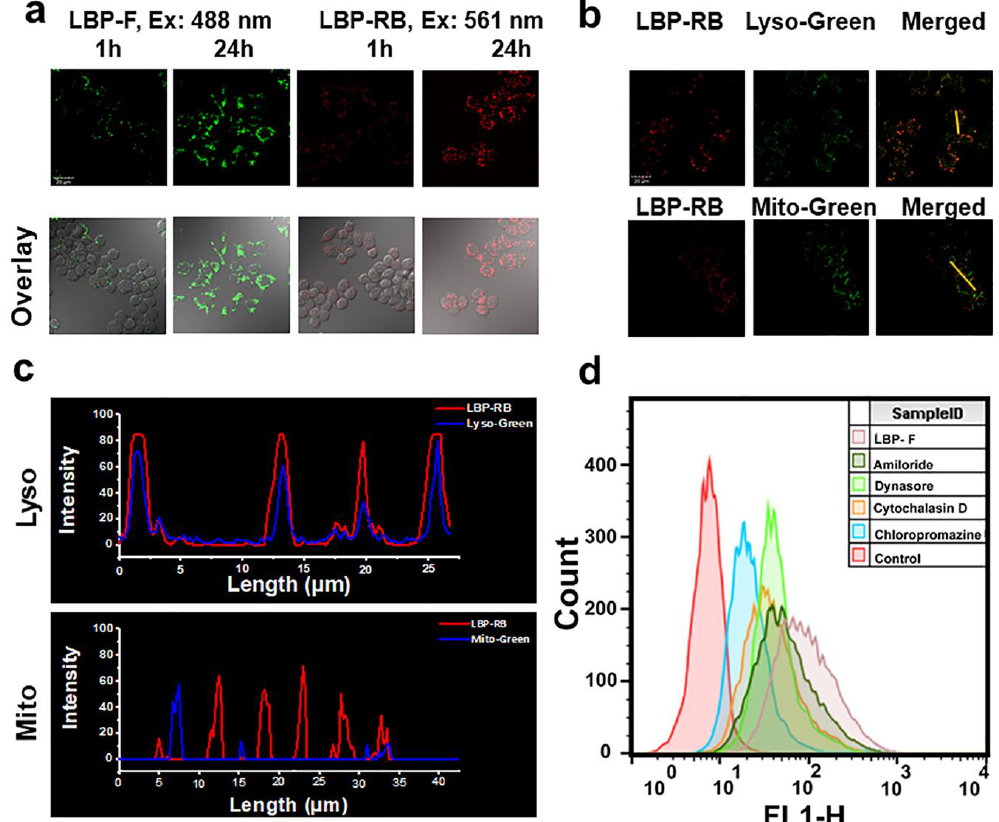
Figure 4. ( a ) Confocal imaging of RAW264.7 cells after incubation with 100 μg/mL LBP-F/LBP-RB after 1h and 24 h, (scale bar, 50 μm); ( b ) Confocal imaging of Raw264.7 cells stained with LBP-RB (100 μg/mL, λex = 561 nm) and Lyso Tracker-Green (500 nM, λex = 488 nm) or Mito Tracker-Green (100 nM, λex = 488 nm), (scale bar, 50 μm); ( c ) fluorescence intensity profile of line regions in ( b ) of LBP-RB and Lyso-Green/Mito-Green; ( d ) the effects of inhibitors on the internalization of LBP-F measured by flow cytometry.